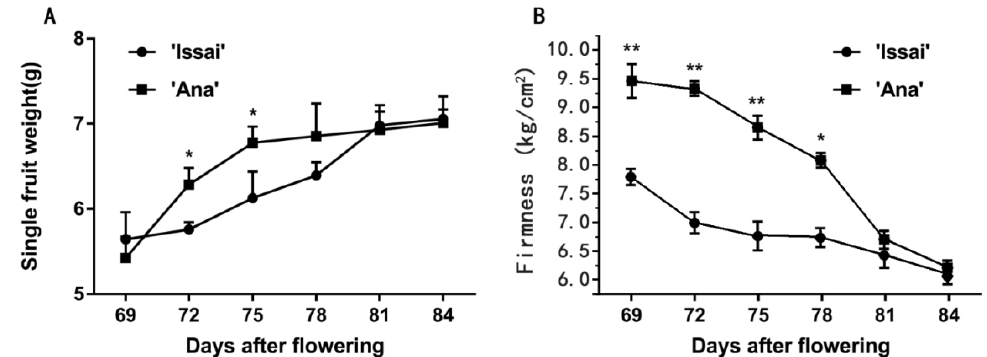
Figure 1. The effect of maturity stage at harvest on changes in fresh weight ( A ) and flesh firmness ( B ). Data are presented as mean ± standard error from three biological replicate assays (** p < 0.01, * p < 0.05). The error bars represent standard error of the